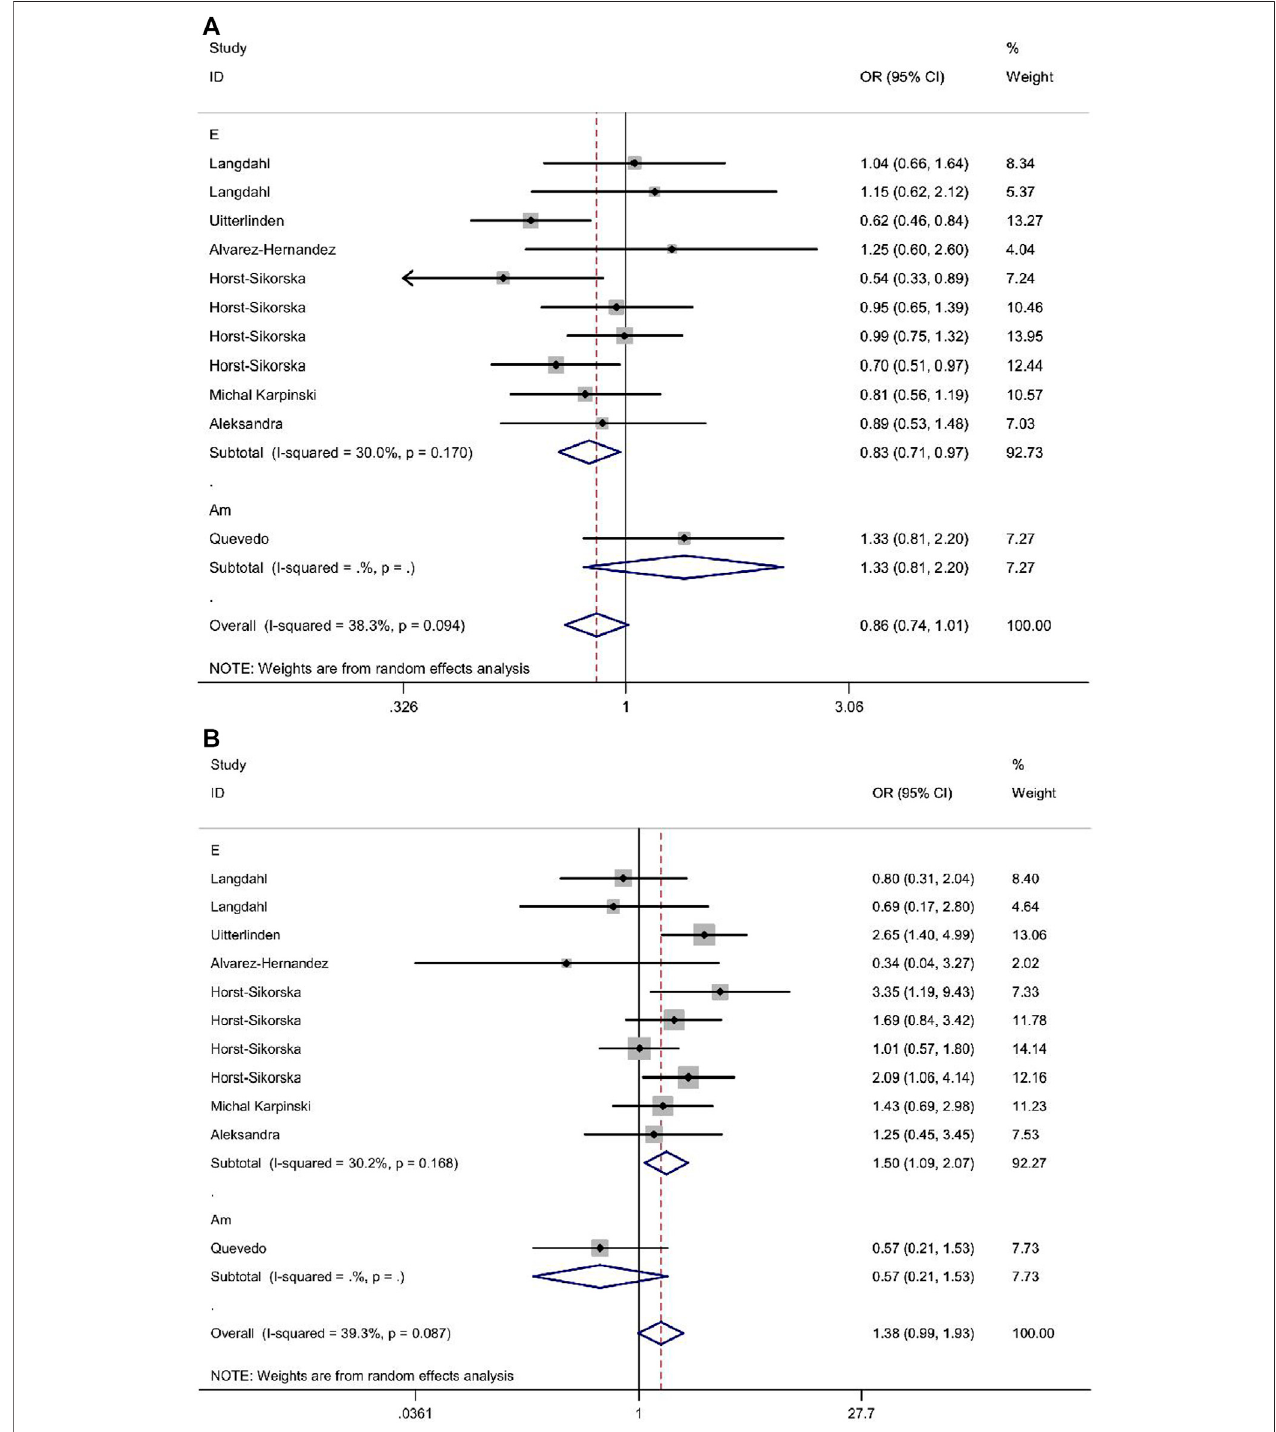
FIGURE3| ForestplotsofallselectedstudiesontheassociationbetweenVDRApalpolymorphism and theriskofosteoporoticfractureindifferentraces [ (A) allele model, (B) additive model, (C) dominant model, and (D) recessive model].